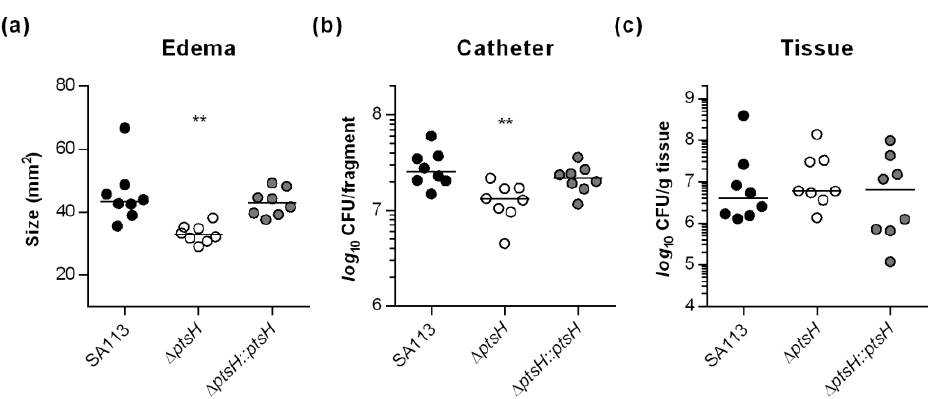
Figure 6. Inactivation of ptsH reduces the infectivity of S. aureus SA113 in a murine foreign body infection model. Catheter fragments were implanted subcutaneously into the back of normoglycemic mice and inoculated with cells of S. aureus strains SA113 (black symbols), its ptsH deletion mutant (white symbols), and the cis-complemented ptsH mutant (grey symbols), respectively ( n = eight animals per group). Ten days post infection, animals were euthanized, edema sizes around the implanted catheters were measured ( a ), and the catheters and surrounding tissues were explanted. Bacterial loads from catheter detached biofilms ( b ) and in surrounding tissue homogenates ( c ) were determined by CFU counting. The data represent the values of every individual animal (symbols) and the median (horizontal line). **, p < 0.01 (one-way ANOVA and Holm-Sidak’s multiple comparison test).